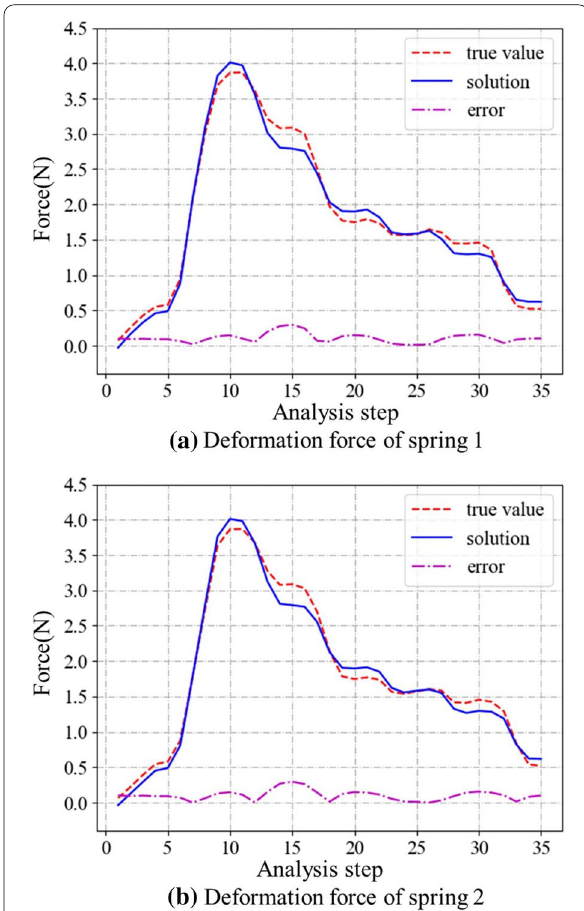
residual stress inside the workpiece. We compared the deformation corresponding to the solved results with the deformation corresponding to the benchmark ini- tial residual stress field (as shown in Figure 5(a)) to ver- ify the effectiveness of the solved results. We extracted the deformation according to the position shown in Figure 5(b). The deformation caused by initial resid- ual stress of the workpiece was mainly warping, so we extracted the variation in the Y -direction as the defor- mation of the workpiece.